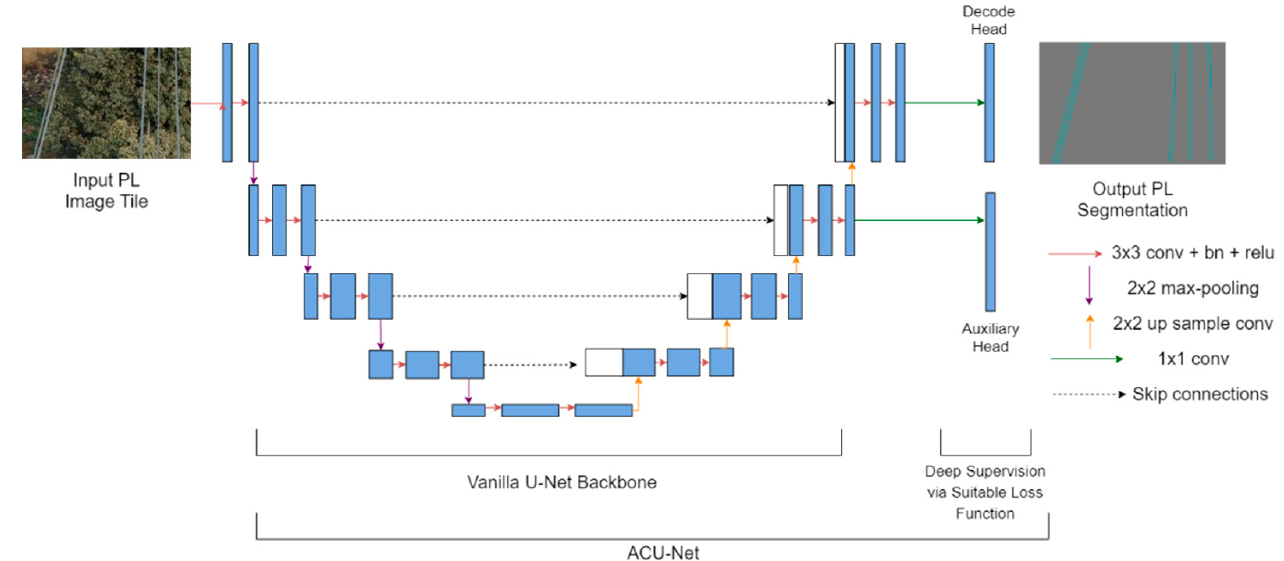
Figure 1. Proposed auxiliary classifier-U (ACU)-Net architecture with additional auxiliary head for better feature learning and model convergence.